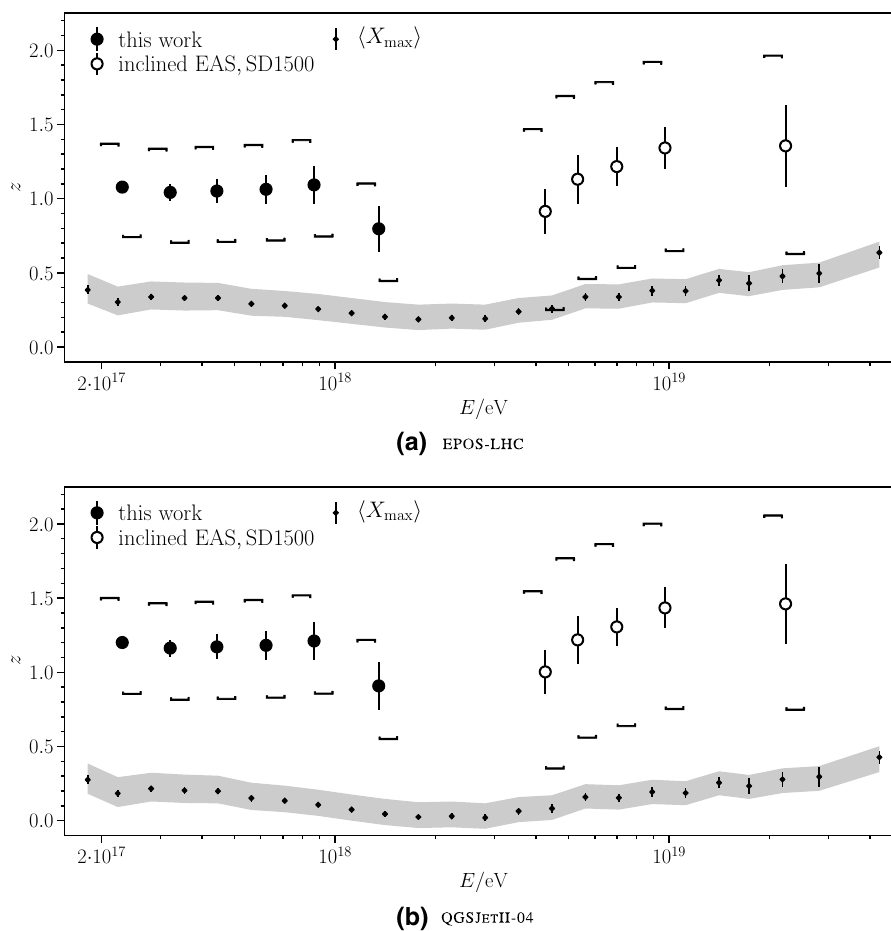
Fig. 13 z -factor obtained from this work (filled circles) and from measurements of inclined EASs higher in energy by a decade and a half (open circles) for the EPOS- LHC ( a ) and the QGSJetII- 04 ( b ) hadronic interaction models. Also shown in both cases are the results obtained from measurements of the mean depth of shower maximum (cid:14) X max (cid:15) by the